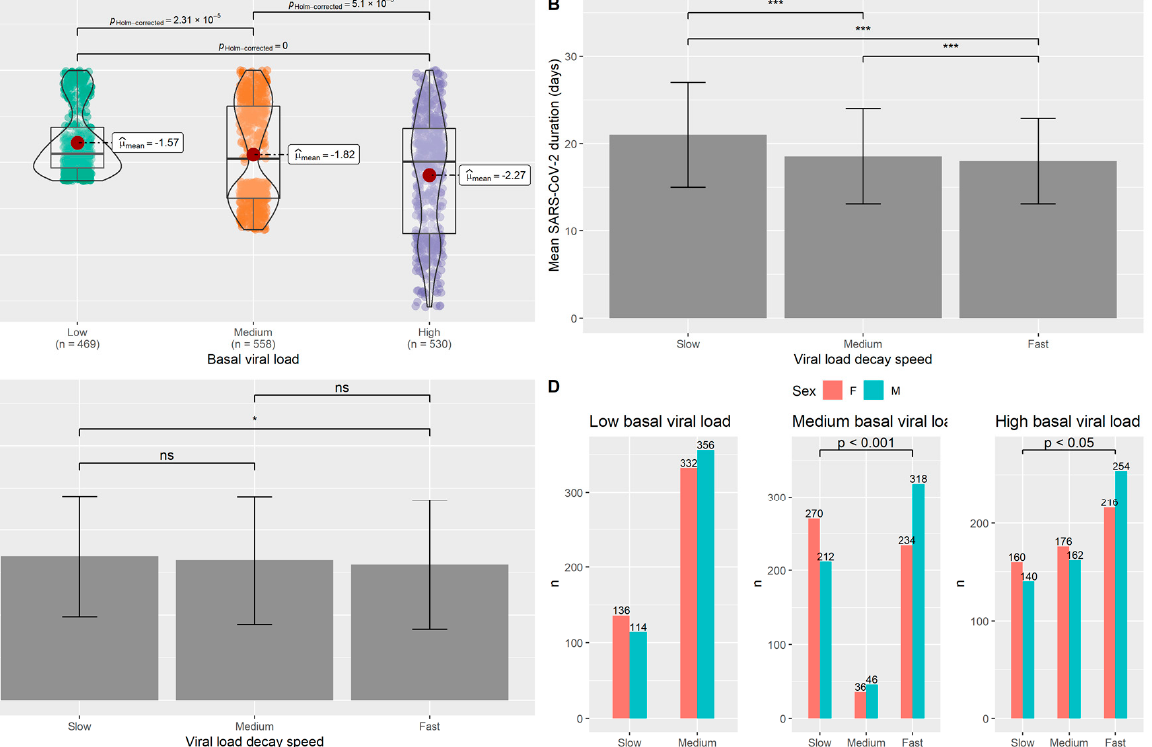
Figure 2. Analysis of the OSs carriers group. ( A ) VLDS showed to be dependent on the basal viral load, proving the need of stratifying according to viral load inside the group. ( B ) The duration of infection significantly differs among individuals with different VLDS. ( C ) Age was found to be significantly different between individuals with low and high viral loads. ( D ) Sex distribution was different among individuals with different ranges of viral load. Male sex was found to be significantly present in the group of individuals with high and medium viral loads characterized by fast VLDS. n = number of subjects; * p < 0.05; *** p <